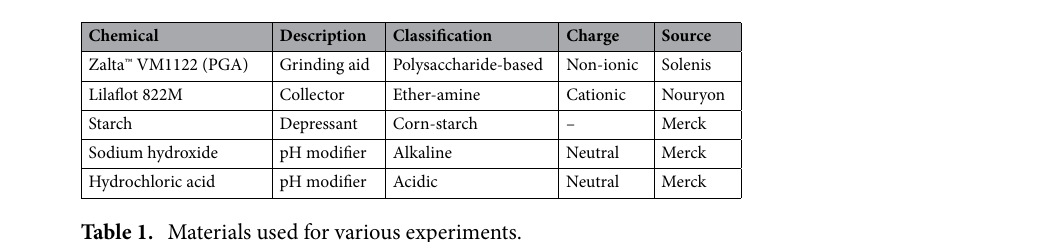
Table 1. Materials used for various